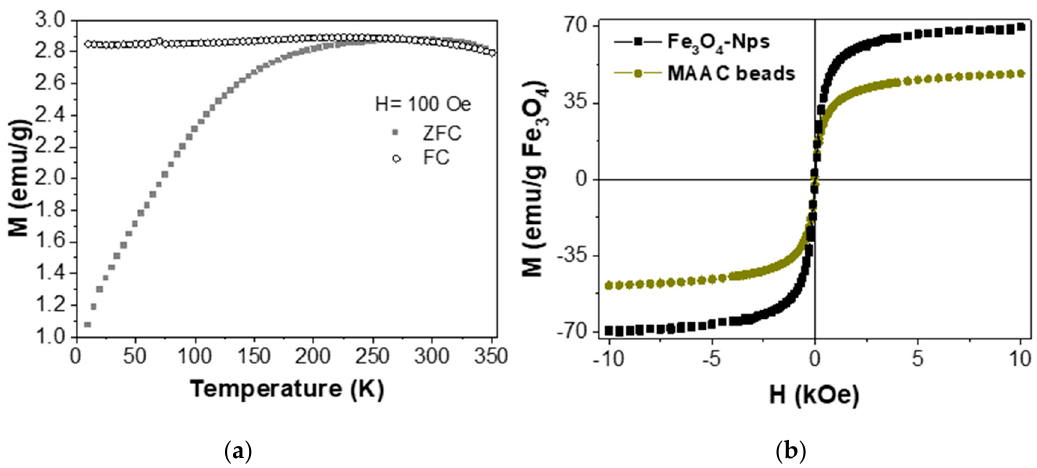
Figure 3. ZFC and FC curve recorded at 100 Oe ( a ) and magnetization curve of MAAC bead and Fe 3 O 4 -NPs at 25 °C ( b